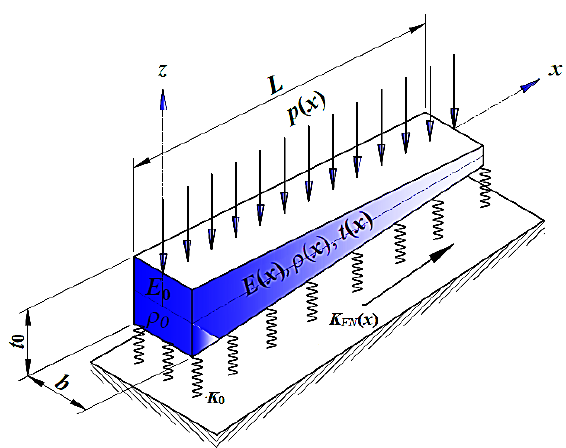
Figure 1. Non-uniform AFG beam model with variable foundation and